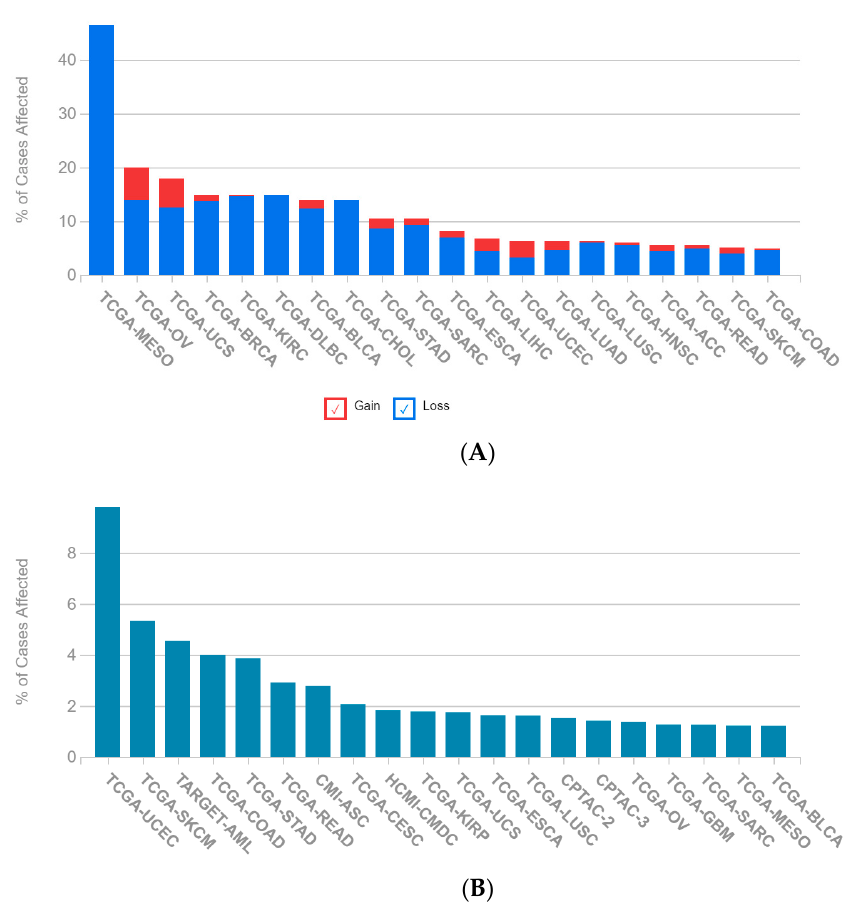
Figure A4. CNV and mutation distribution of DAG1 in different cancer types. ( A ) CNV distribution. ( B ) Mutation distribution.